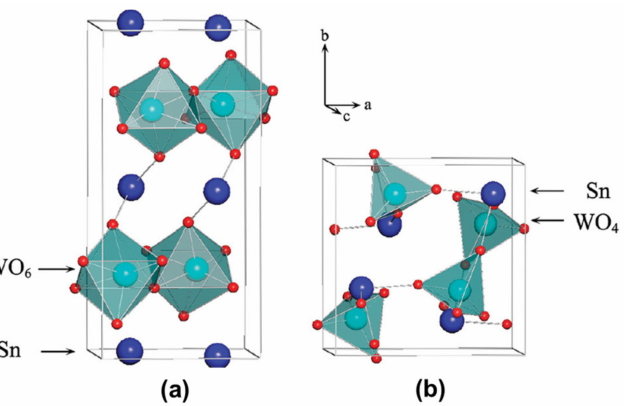
Figure 1. Crystal structures of SnWO 4 polymorphs: ( a ) α -SnWO 4 (orthorhombic); ( b ) β -SnWO 4